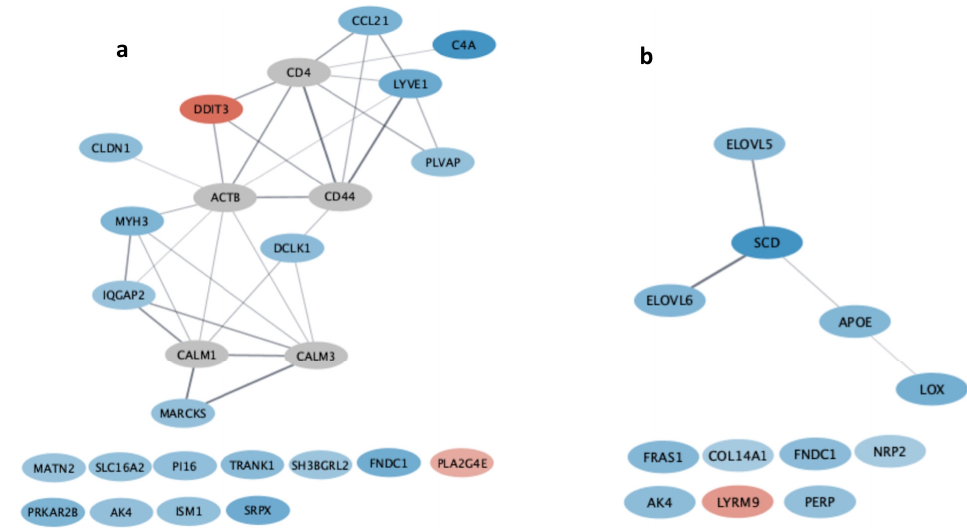
Figure 1. Cytoscape Gene networks achieved with stringApp for the DEGs obtained comparing D1 vs. D3 diets on the left ( a ) and D1 vs. D4 diets on the right ( b ). Over-expressed genes were colored in shades of blue, from the lightest (least over-expressed) to the darkest (most over-expressed). Down-expressed genes were colored in shades of red, from the lightest, least under-expressed to the darkest, most under-expressed. The genes indicated with a gray ellipse are additional interactor genes selected by Cytoscape.